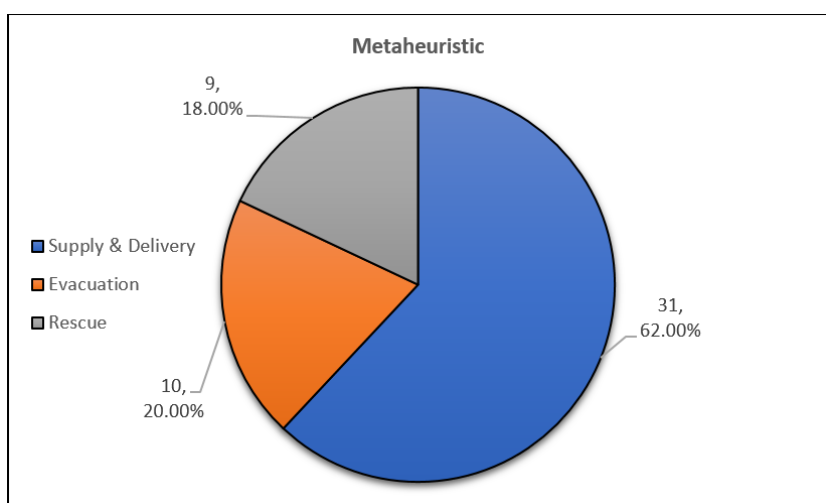
Figure 30. Selected Humanitarian Operation based on Metaheuristic